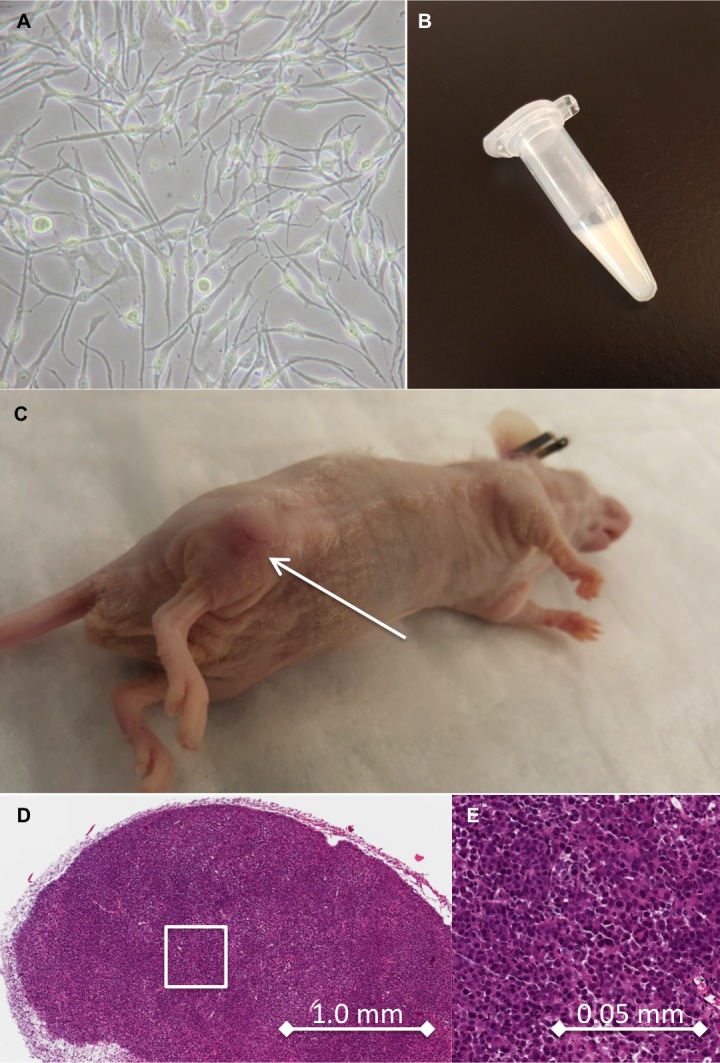
In vitro, In vivo and Ex vivo Characteristics of Human DB-1 Melanoma Cells.(A) DB-1 cells in culture at 40X magnification. (B) Cell pellet demonstrating amelanotic characteristic of cells. (C) Typical xenograft tumor on flank of an athymic nude mouse. Arrow pointing towards lesion. (D) H&E stain at 42X magnification of section through harvested tumor. Inset represents region shown in panel E at 840X magnification.